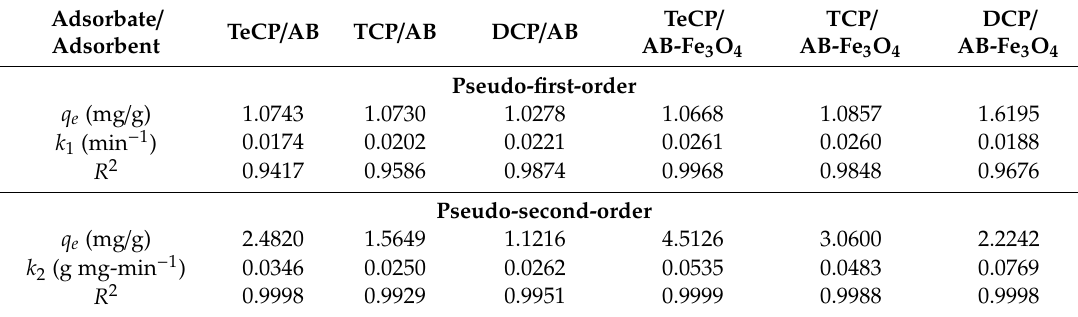
Figure 6. E ff ect of contact time on the uptake of TeCP, TCP, and DCP on ( a ) AB and ( b ) AB-Fe 3 O 4 at pH 3.5 ( C 0 = 5 mg / L, V = 30 mL, adsorbent mass 30 mg, and agitation speed = 300 rpm). C indicates the remaining concentration of TeCP, TCP, and DCP in the solution at time t . Table 3. Kinetic parameters of TeCP, TCP, and DCP adsorption by AB and AB-Fe 3 O 4 .